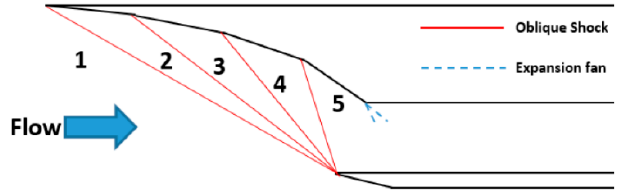
Figure 17. Ideal oblique shock propagation for the four ramp inlet.